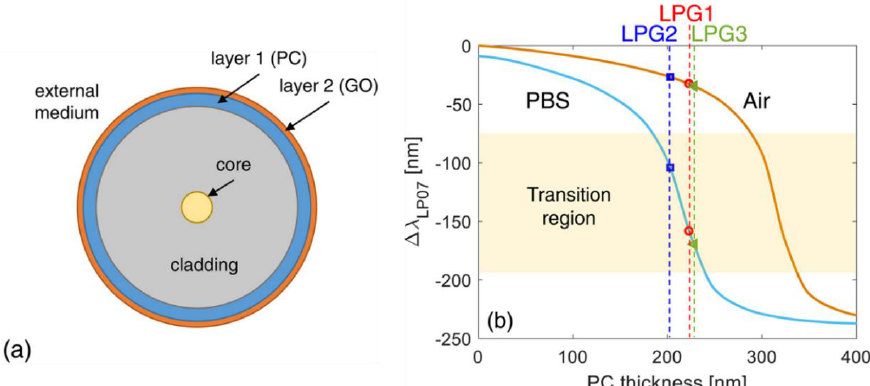
Figure 6. ( a ) The structure of multilayer fibers. ( b ) Numerical wavelength shift of the attenuation band versus PC overlay thickness. Reprinted with permission from [51]. Copyright © 2018 Elsevier